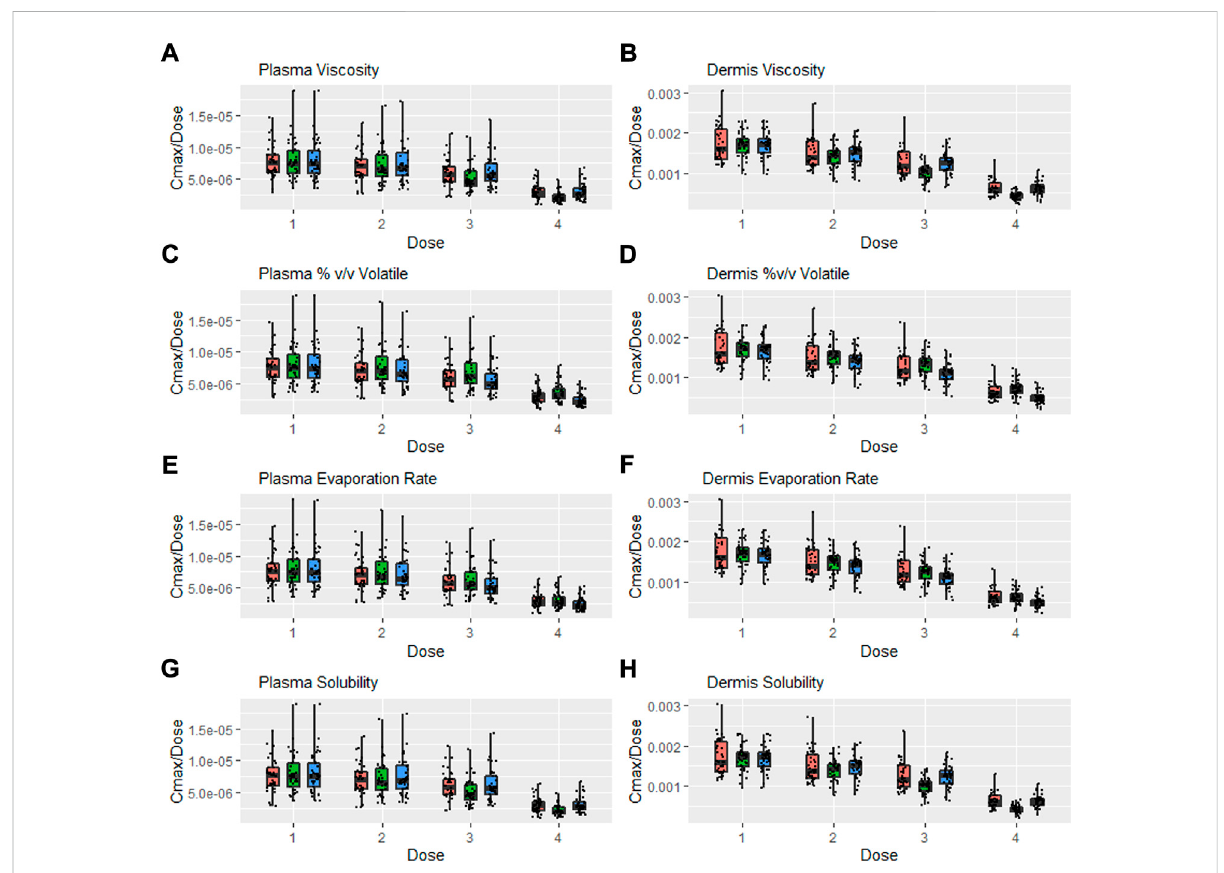
FIGURE 8 Interaction between formulation parameters and different dosing scenarios, C max /Dose = C max /Number of Sprays (i.e., 5, 25, 50, and 3.5 for Dose 1, 2, 3, and 4 respectively); viscosity (A,B) , %(v/v) volatile fraction (C,D) , evaporation rate (E,F) and solubility of drug in the continuous phase (G,H) . Red bars represent RLD parameter value, Green = Upper bound and Blue = Lower bound